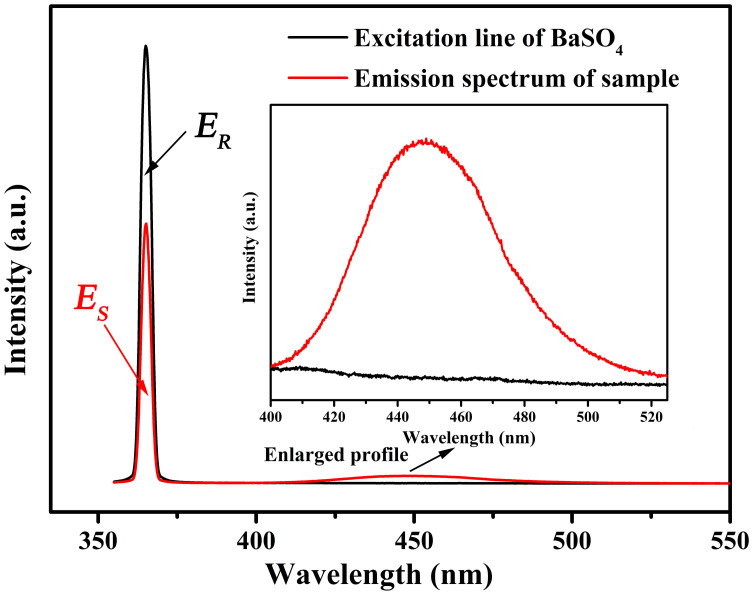
Excitation line of BaSO4 and emission spectrum of the KMg4(PO4)3:0.01Eu2+ phosphor collected by an integrating sphere.The inset shows the magnification of the emission spectrum.